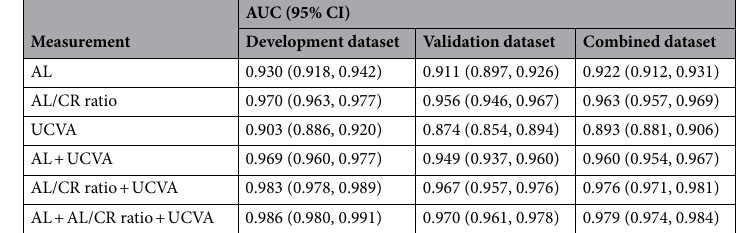
Table 5. Area under ROC curve for detecting myopia using single biometric measure or uncorrected visual acuity or their combinations. AL axial length, AL/CR ratio axial length/corneal curvature radius ratio, UCVA uncorrected visual acuity, AUC area under ROC curve, 95% CI 95% confidence